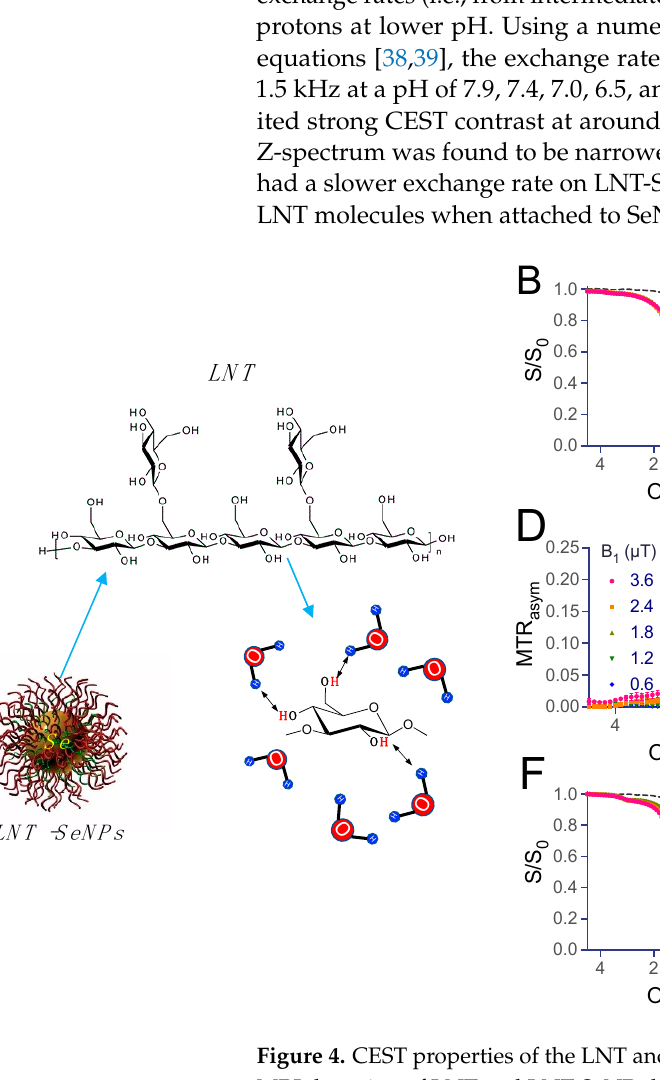
Figure 4. CEST properties of the LNT and LNT-SeNPs. ( A ) Schematic illustration of label-free CEST MRI detection of LNT and LNT-SeNPs by their inherently carried hydroxyl protons. ( B ) Z-spectra and ( C ) MTR asym plots of 3.6 mg/mL LNT (~20 mM glucan) at different pH values. ( D ) Dependency of MTR asym plots on B1 in the range from 0.6 to 3.6 µT. ( E ) pH dependency of the MTR asym values at 1 ppm. ( F ) Z-spectra and ( G ) MTR asym plots of 5 mg/mL LNT-SeNPs at different pH values.